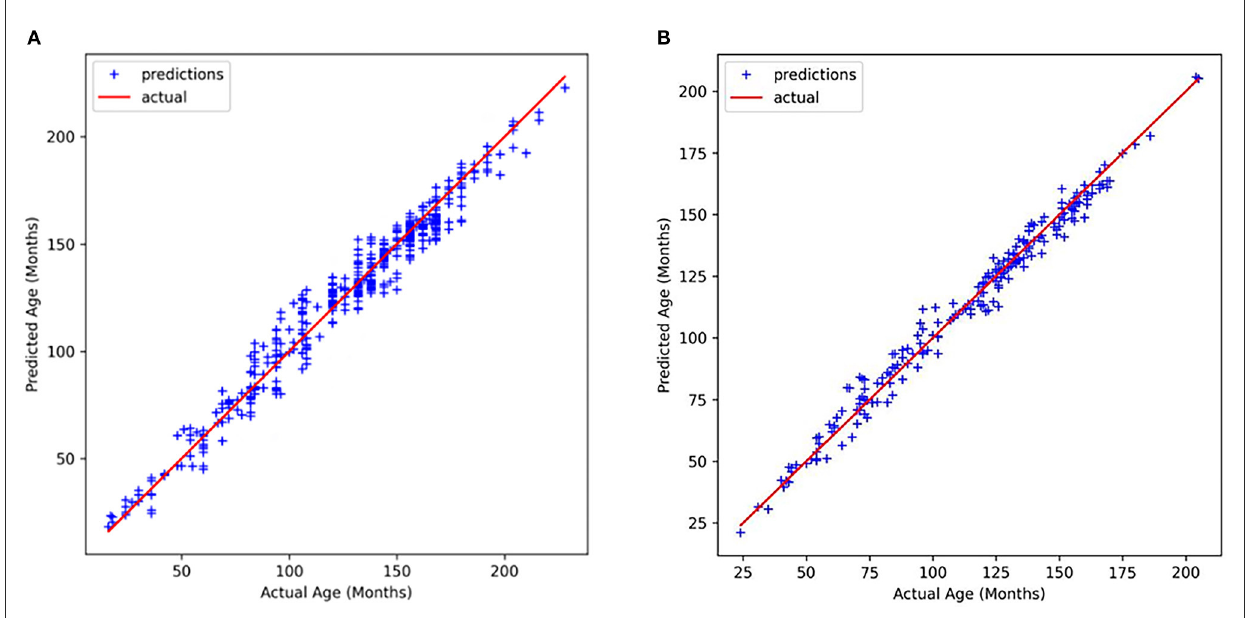
FIGURE10 Relationship between actual age and predicted age (A) RSNA dataset, (B) CQJTJ dataset.